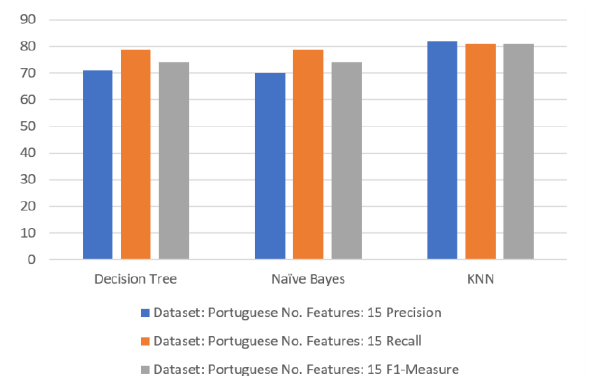
Table 7. Classification report with feature selection.